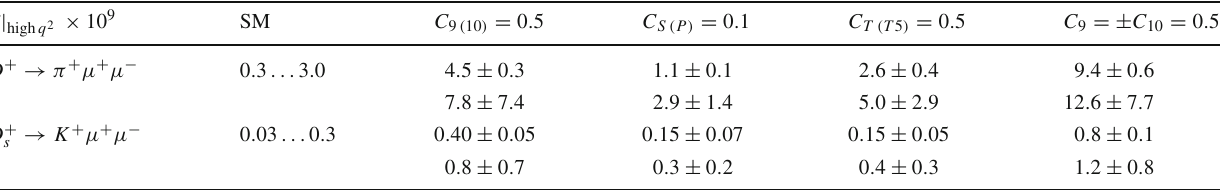
(cid:24) q 2 ≥ ing ratios while for the lower entries the resonance contributions are taken into account = 0 . 5 C = 0 . 1 C = 0 . 5 S ( P ) T ( T 5 ) 9 ( 10 )